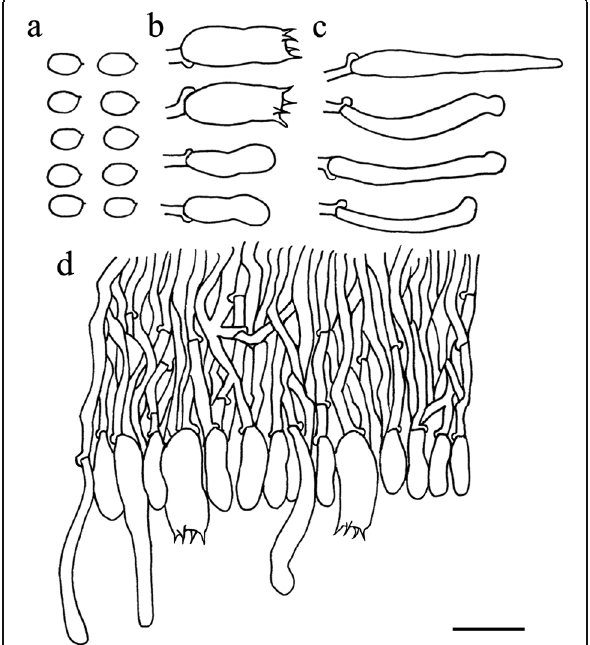
Fig. 13 Microscopic structures of Skvortzoviella lenis (drawn from holotype). a basidiospores. b basidia and basidioles. c leptocystidia. d a section of hymenial and subhymenial layer. Scale bar = 10 μ